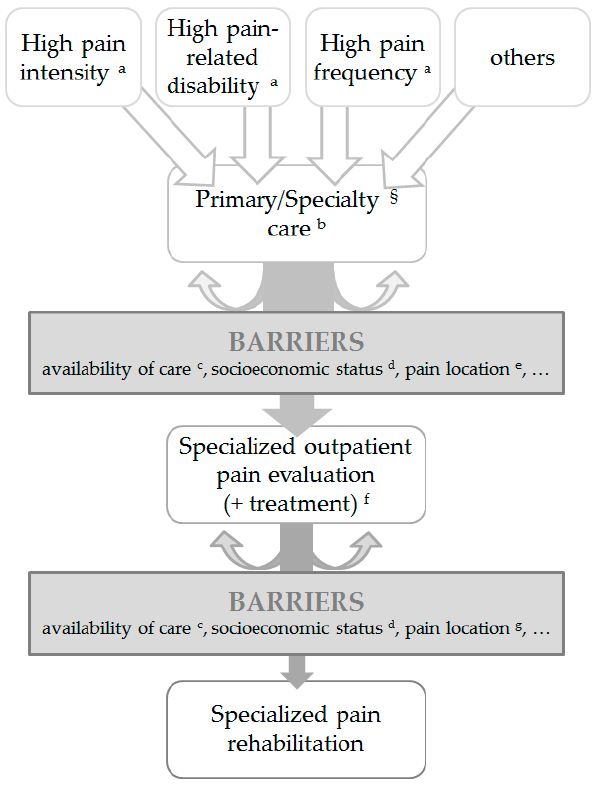
Figure 1. Usual course of health care utilization due to chronic pain. § e.g., rheumatologists, neurologists, gastroenterologists, orthopedic surgeon. a e.g., [1,10–12]; b e.g., [11,15–17]; c e.g., [19–21]; d e.g., [19,20]; e e.g., [26]; f e.g., [25–27]; g e.g., [28].